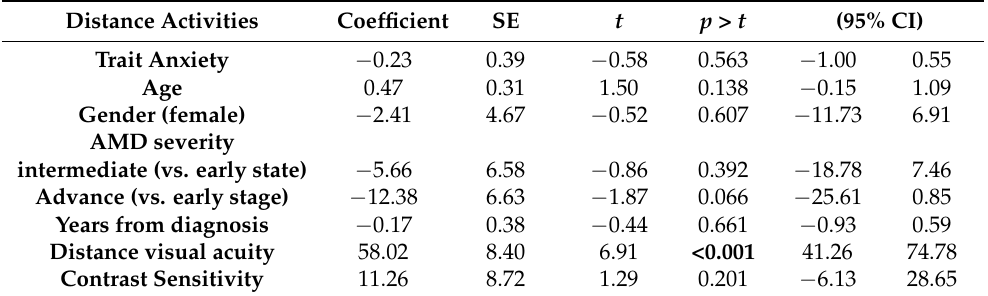
Table 5. Multiple linear regression model that correlates trait anxiety with the subscale Distance Vision from the quality-of-life questionnaire NEI-VFQ-25.